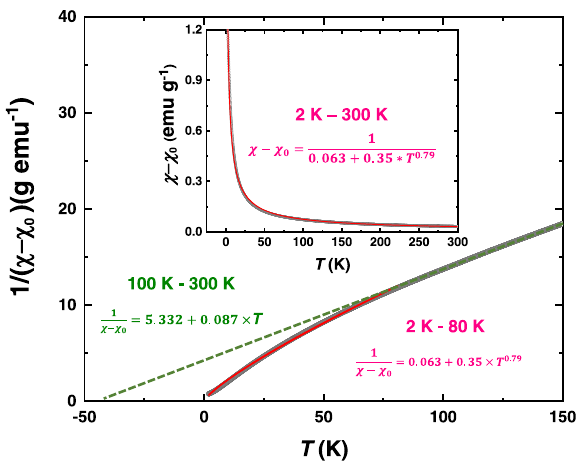
Fig. 6 Magnetic properties of TiFe 1.33 Sb. Temperature-dependent magnetic susceptibility of TiFe 1.33